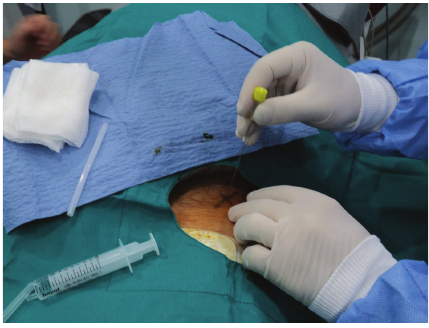
Figure 2: Entry point is